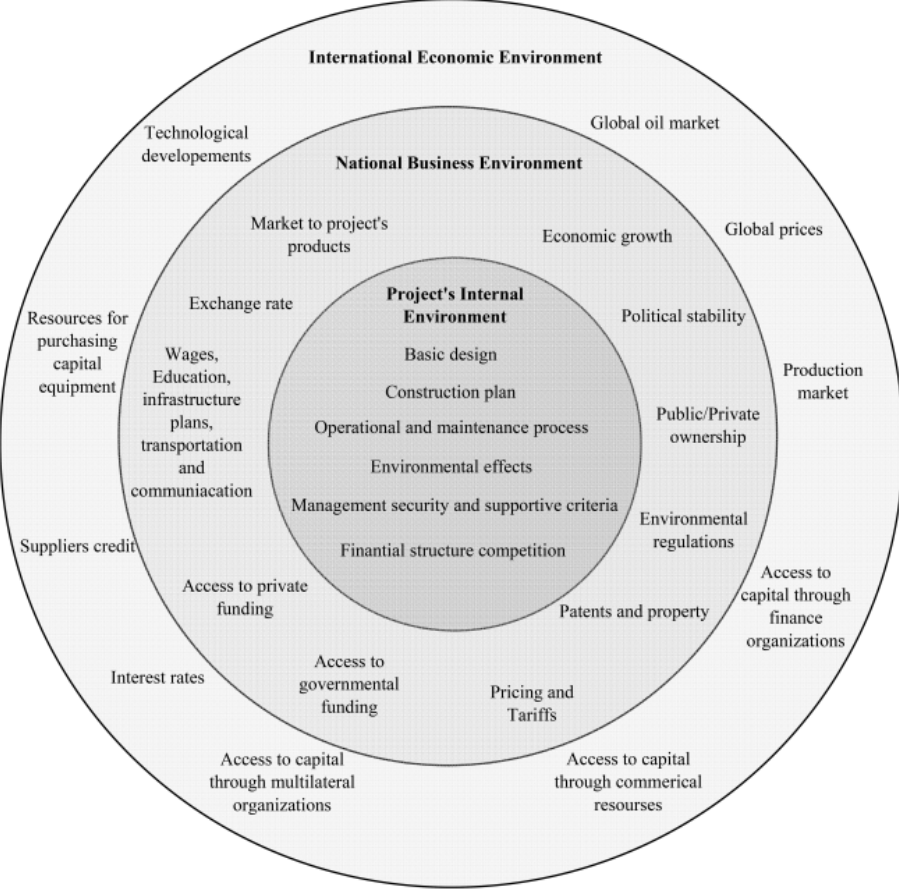
Figure 1. Different levels of characteristics surrounding a construction project (adapted from [4]).